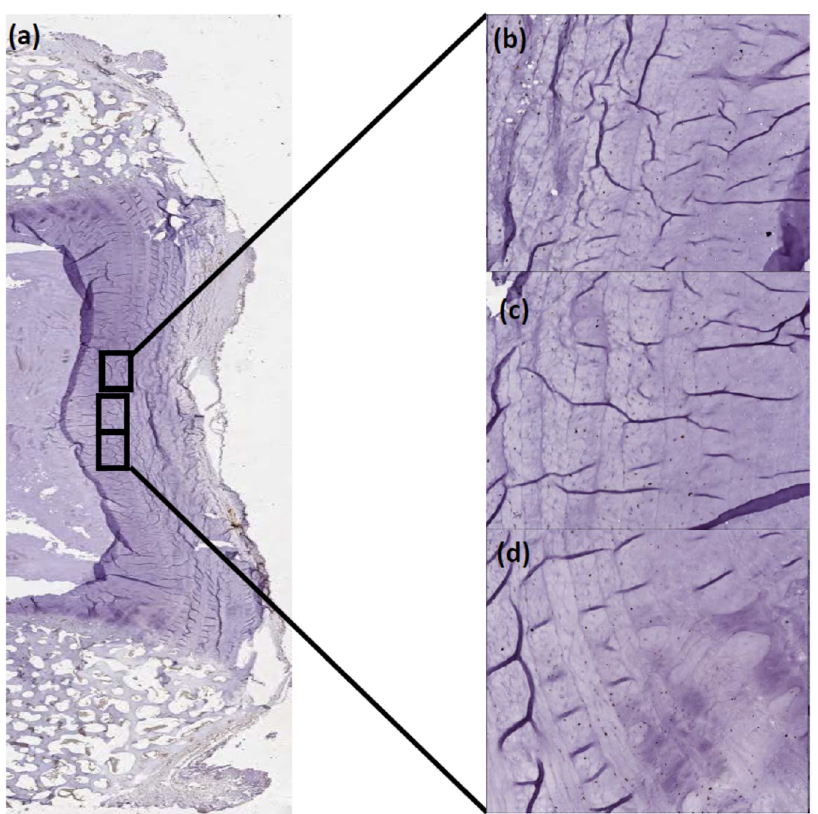
Figure A1. ROI determination for scanned IVD sections. ( a ) The posterior aspect of each scanned tissue section was examined at low power (×2-4) and then at higher power (×20). ( b–d ) Each of three distinct regions at ×20 magnification were selected and immunostained cells were quantified using the Indica Labs IQ4 software programme.